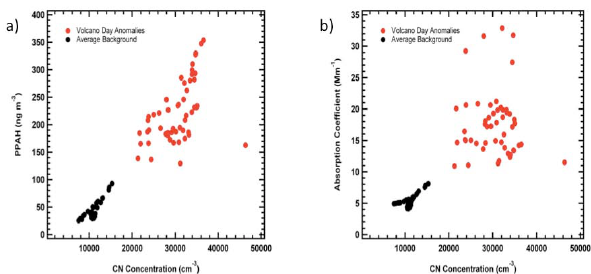
Fig. 7. Correlation between (a) PPAH and CN concentrations and (b) absorption coefficient and CN concentrations, for the average background day (black dots) and days when the volcanic influence was detected (red